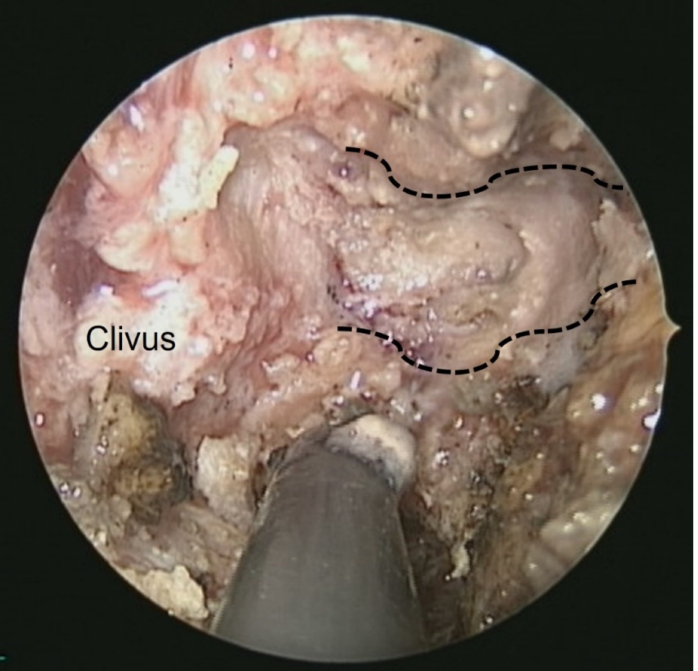
Figure 2. Intra-operative endoscopic view from the nose: the left side hypoglossal canal (black dashed line) and underlying lower cranial nerves were